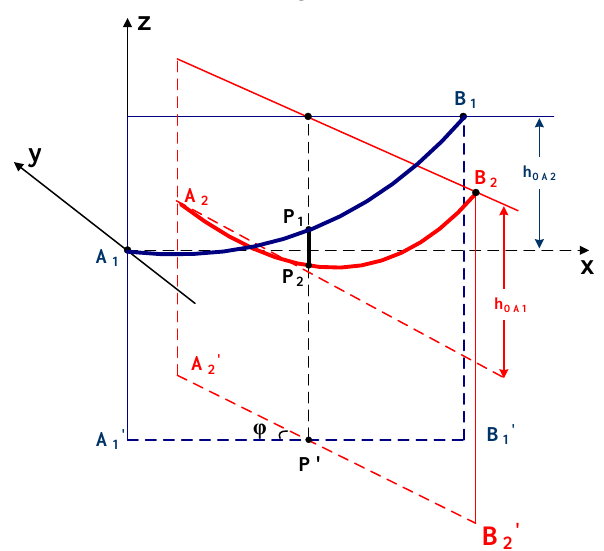
Figure 2. The diagrammatic sketch of crossed span under windless condition The arc A 2 P 2 B 2 passes below A 1 P 1 B 1 , P 1 and P 2 are the crossing points, P' is the projection of P 1 P 2 to the ground, |P1P2| is the crossing span distance. and are the